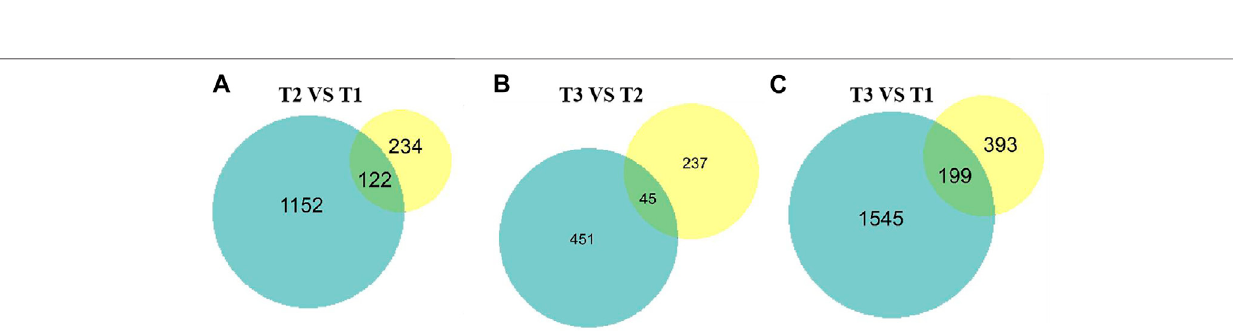
Frontiers in Cell and Developmental Biology |